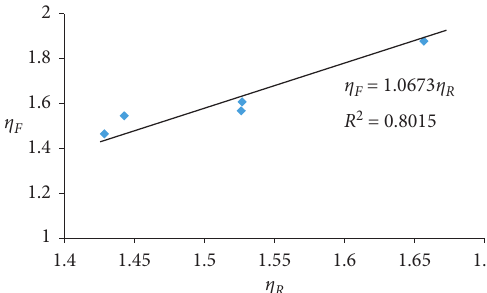
Figure 6: The correlation diagram of η